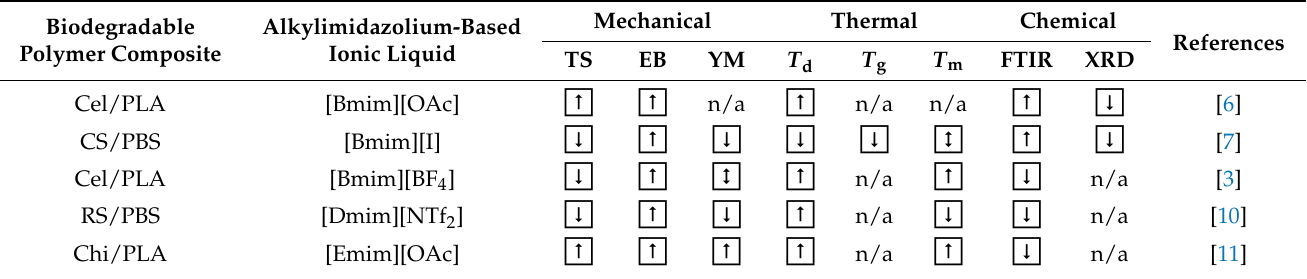
Table 6. Mechanical, thermal, and chemical properties of biodegradable polymer composites influenced by alkylimidaz- olium-based ionic liquids. TS = tensile strength, EB = elongation at break, YM = Young’s modulus, T d = decomposition temperature, T g = glass transition temperature, T m = melting temperature, FTIR = Fourier transform infrared, and XRD = X-ray diffraction. The symbol ‘ ⬆ ’ corresponds to an increase in the properties, and ‘ ⬇ ’ corresponds to a decrease in the properties, while ‘ ↕ ’ and ‘n/a’ describe unchanged and not available, respectively. Table 7 indicates the mechanical, thermal, and chemical properties of biodegradable